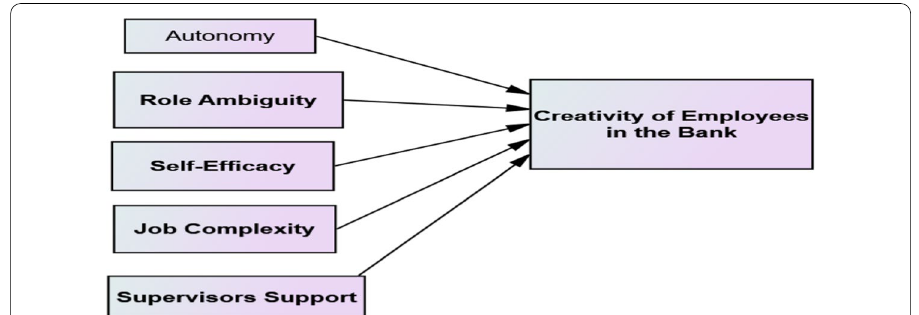
Fig. 1 Conceptual framework of the study ( source: proposed by the researcher